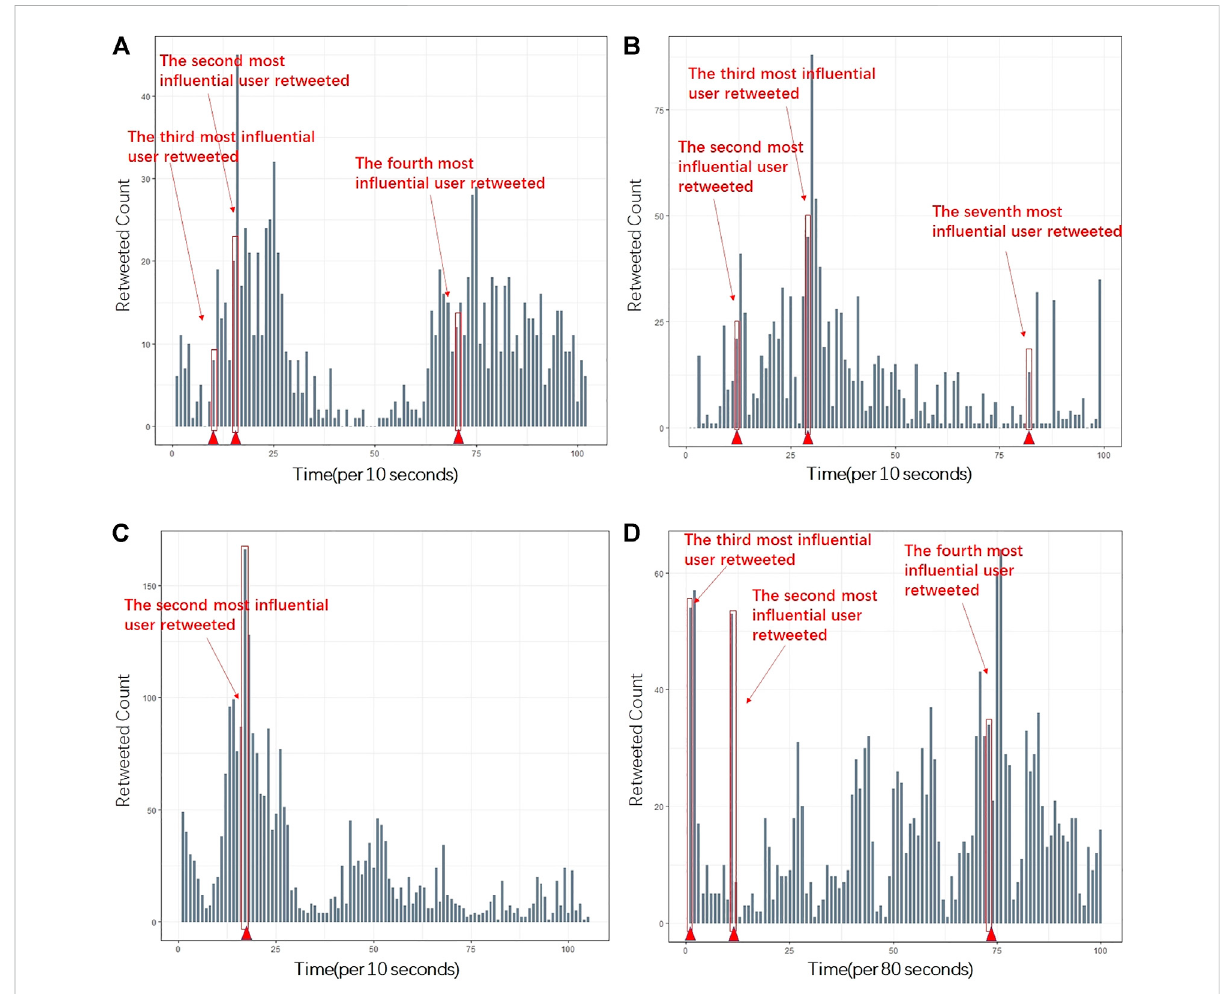
FIGURE 3 Four representative sequences of tweets propagation with top super spreaders marked. Panel (A) , (B) , (C) , and (D) corresponds to tweet (a), (b), (c),(d)respectively.Duetodifferenttotaltimelengthsofthetweetsunderconsideration,theunitofthehorizontalaxesinA,B,C,andDare10 s,10 s, 10 s, and 80 s, respectively. (A) shows stable propagation and slight fl uctuations. The relative silence period may be due to circadian. (B) illustrates a burst due to the third most in fl uential user. (C) is similar to (B) with only one burst appearing at early stage of the transmission. (D) consists of multiple bursts, which may appear at any stage during the